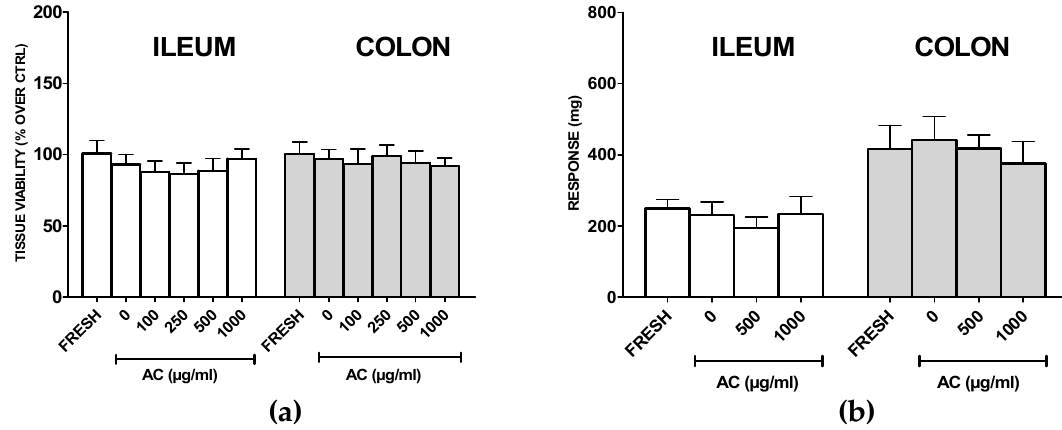
Figure 6. Rat ileum and proximal colon rings’ viabilities ( a ), and high potassium-evoked contraction (KCl 60 mM) ( b ) after treatment with Acacia catechu Willd. extract (AC) for 24 h. Data are reported as means ± SEMs of at least three independent experiments in which four rings/concentrations were run; FRESH and AC 0 µg/mL refer to rings immediately after being explanted or treated with PSS for 24 h, respectively.